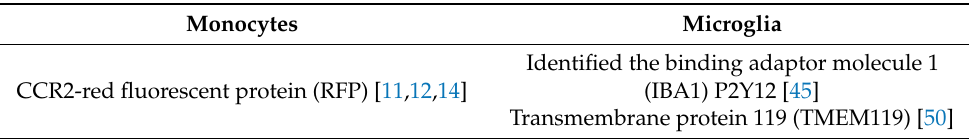
Table 1. Genetic marker of monocytes and